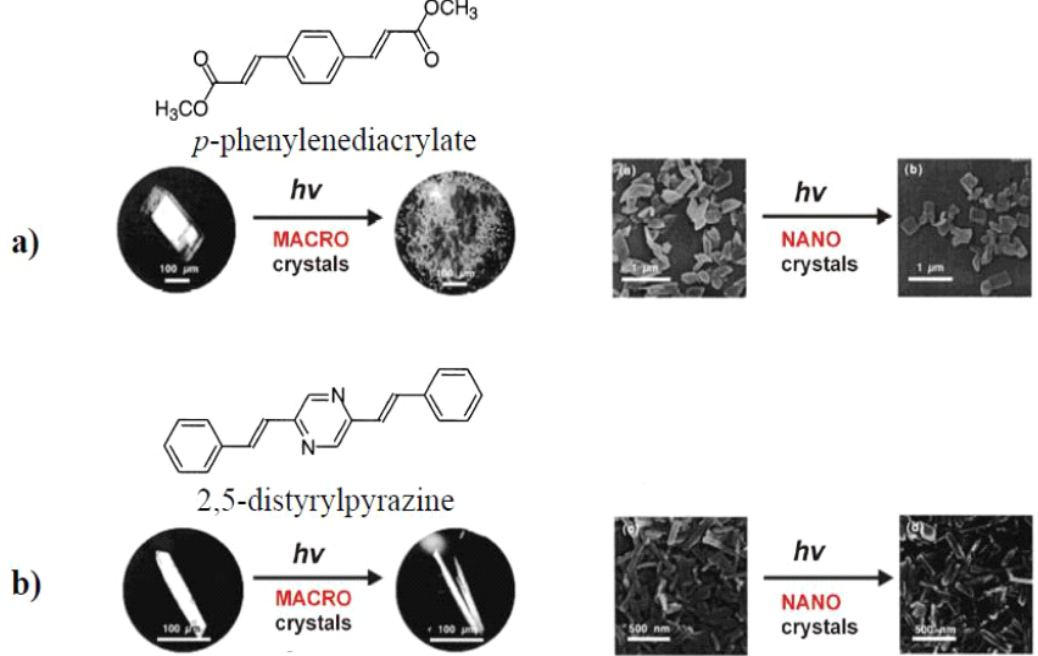
Fig. 1. Morphology of diolefin bulk and nanocrystals before and after UV irradiation observed by SEM. Adapted from Ref